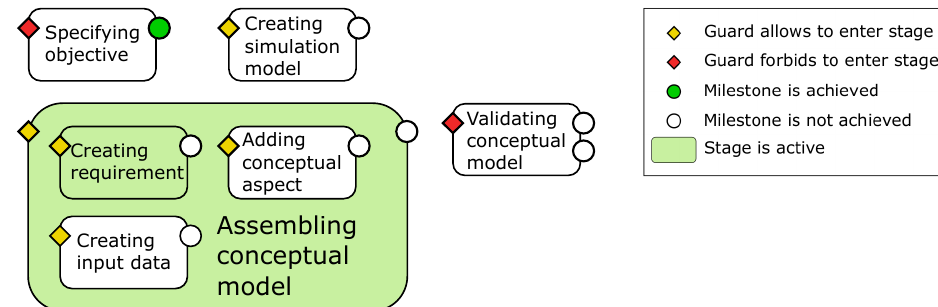
Figure 7. The conceptual model artifact of the artifact-based workflow with all its stages, guards, and milestones, adapted from [73]. Since the milestone of the Specifying objective stage has been achieved, two other stages can be entered: the modeler can start with creating the simulation model, or the conceptual model can be (further) assembled. In this example, the modeler enters the Assembling conceptual model stage and adds a new behavioral requirement. As long as the conceptual model is not fully assembled, it cannot be validated, and therefore, the guard of that stage is disabled.